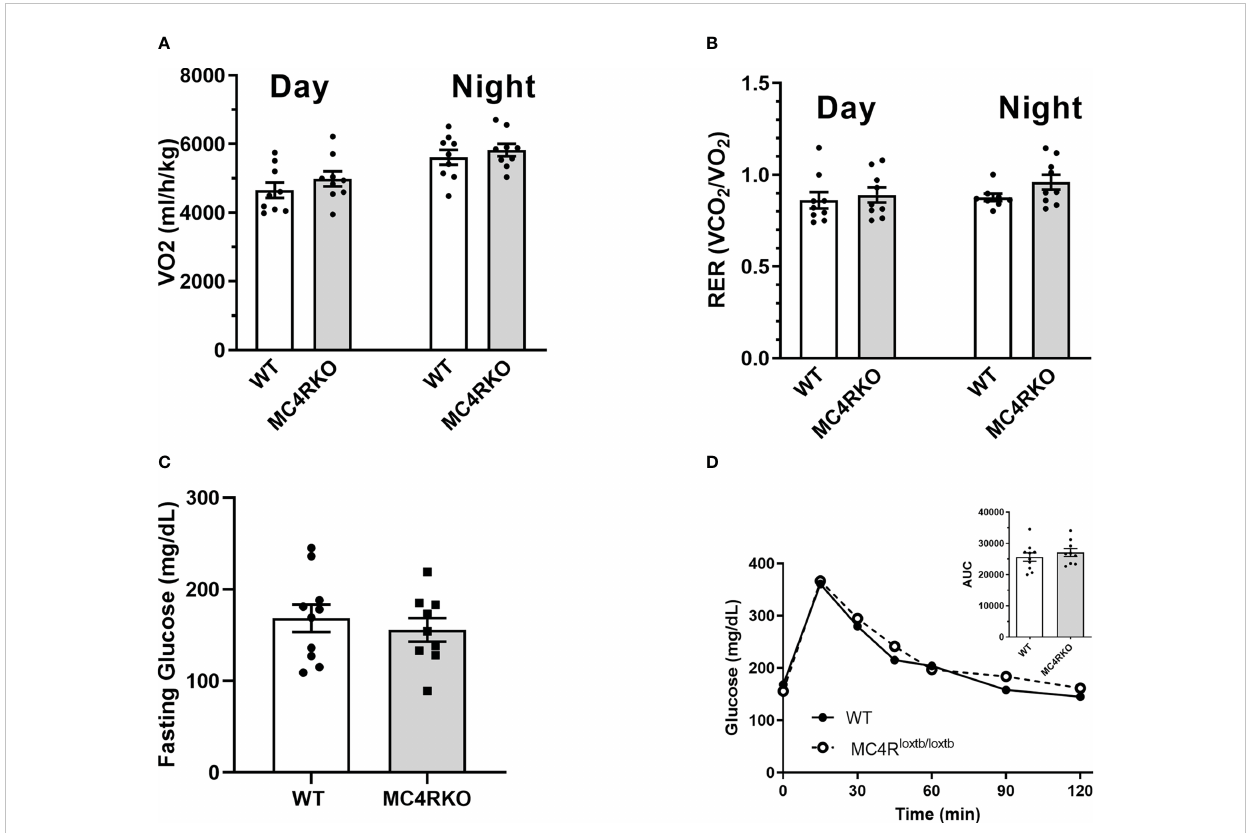
FIGURE 11 Unchanged metabolic rate and glucose sensitivity in MC4RKO females. Oxygen consumption (A) and respiratory exchange ratio (B) during the day and night measured from WT (n=7-9) and MC4RKO (n=8-9) mice in calorimetric cages. Glucose levels in mice after a 6 hour fast (C) and after glucose administration during a glucose tolerance test (D) , with the areas under the curves shown in the inset. Unpaired t-tests were used for all graphs.